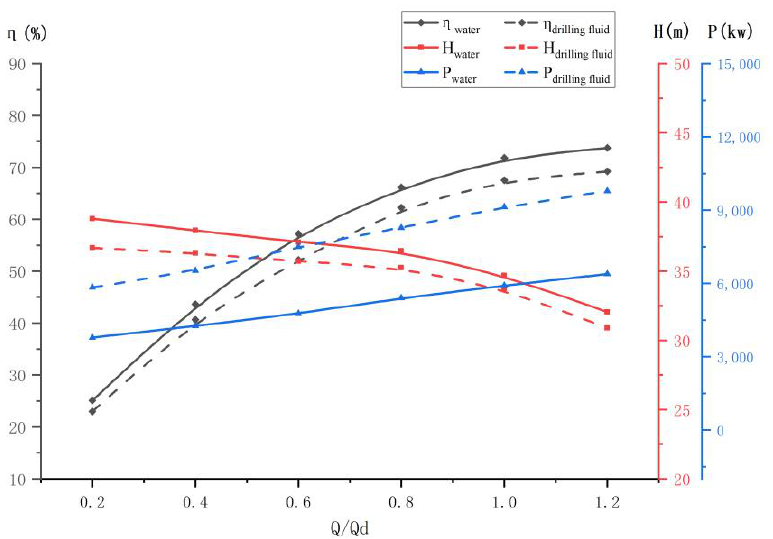
Figure 6. Comparison of the efficiency, head, and power of the water and drilling fluid at different flow flow rates.